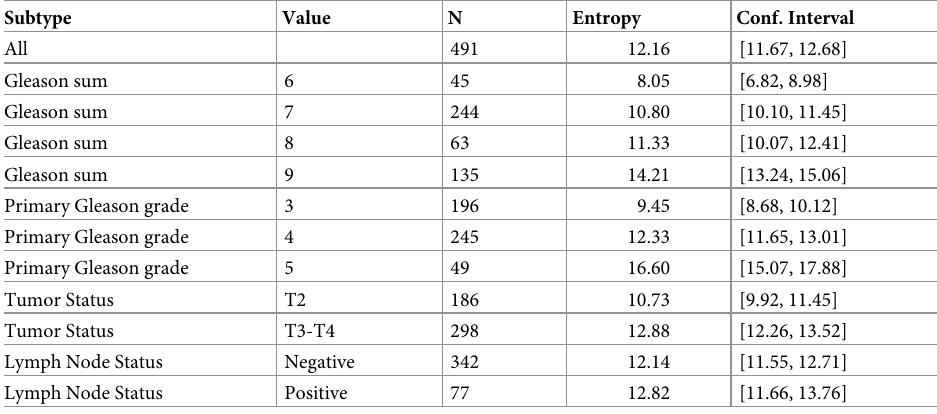
Table 10. Entropy estimation at source level. Entropy estimates for source aberrations with target for prostate Glea- son sum, primary Gleason grade, tumor status, and lymph-node status. N is the total number of samples available in the given